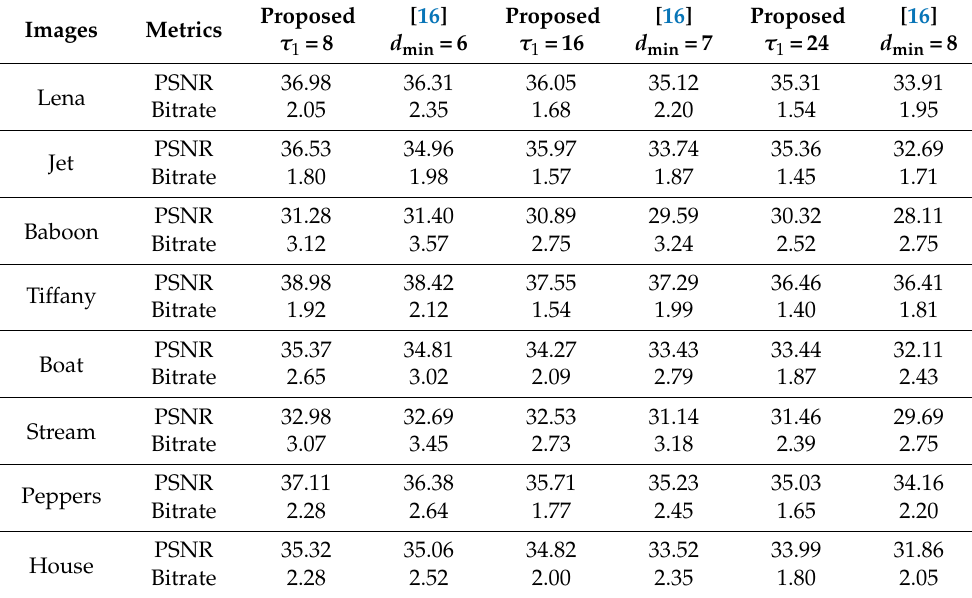
Table 6. Comparisons of PSNR and bitrate with block size 4 ×